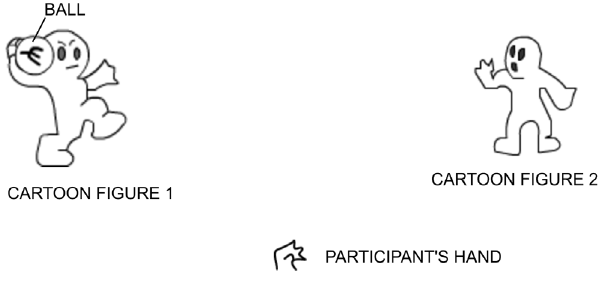
Figure 1. The Cyberball social exclusion task.